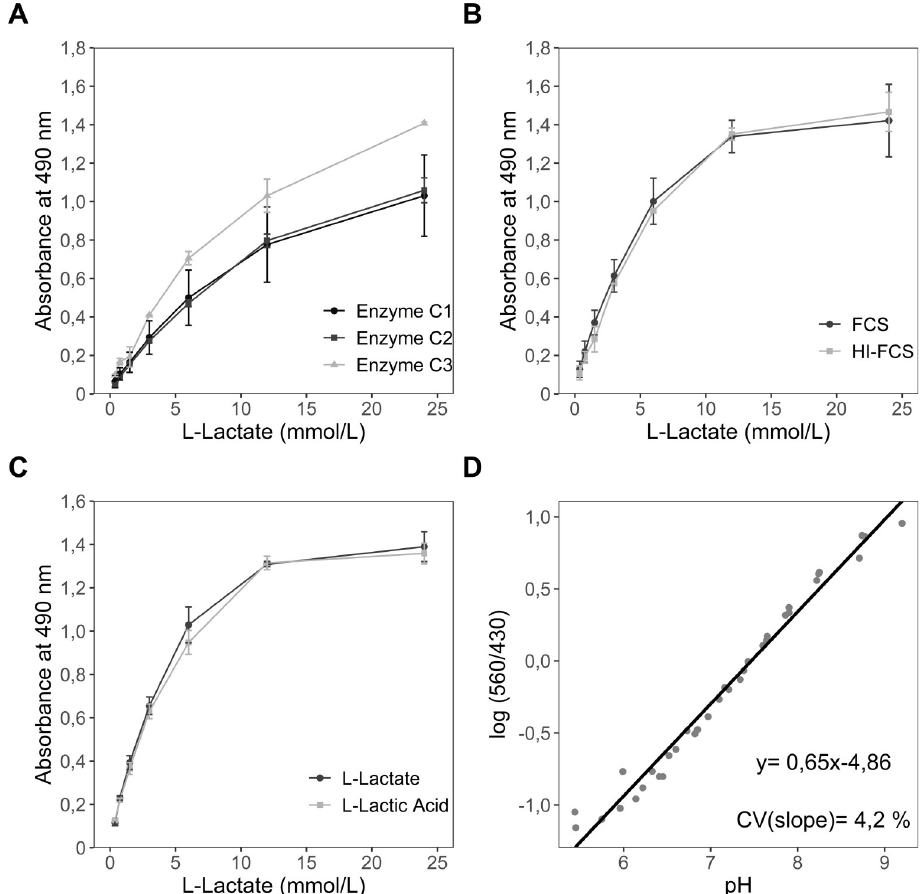
Fig 1. Establishing conditions for L-lactate and pH measurement. (A) Establishment of the conditions for the L- lactate measurement assay was achieved by testing of three different substrate concentrations (Iodonitrotetrazolium chloride; c = 1 mmol/L, 2 mmol/L, 3 mmol/L; only 1 mmol/L shown in graphic) and three different enzyme concentrations (L-lactate dehydrogenase; C1 = 1,73 μ mol/L, C2 = 3,45 μ mol/L, C3 = 6,9 μ mol/L). Two different possible influencing factors (B) FCS and (C) pH on accuracy of measurement were tested. (D) Determination of pH was obtainable from PhR absorbance spectrum and was utilized for calculation of the equation being used for subsequent pH measurements. (A)-(C) The data represents the mean ± sd of two independent experiments. (D) The data represents the mean ± sd of three independent experiments. (A) Pearson´s correlation (r 2 ) = 0,99. For (B) and (C) there is no significance between the conditions tested according to the results of